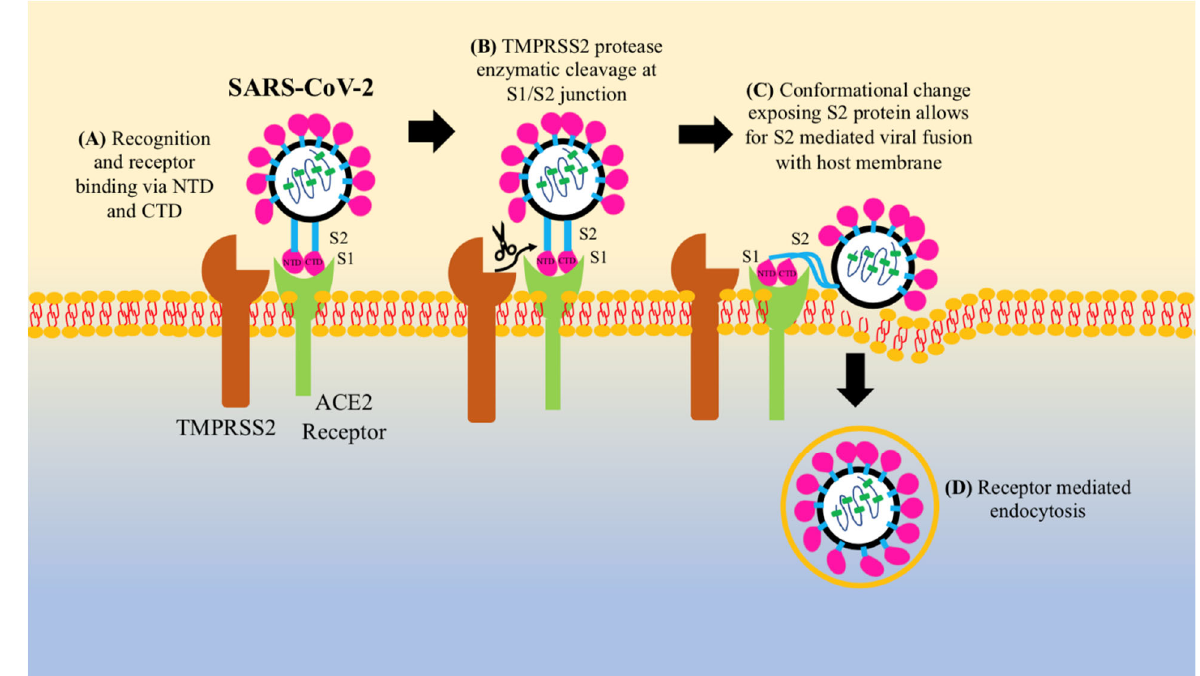
Figure 2. SARS ‐ CoV ‐ 2 mechanism of entry into the host cell. SARS ‐ CoV ‐ 2 is enveloped with a helical nucleocapsid. The envelope is coated by spike proteins, including an S1 and S2 subunit. (A) The S1 subunit has an N ‐ terminal binding domain and a C ‐ terminal binding domain which help with receptor binding and recognition. (B) Once S1 binds to an ACE2 receptor, it undergoes a conformational change with the help of the protease transmembrane protease serine 2 (TMPRSS2) to expose S2. (C) S2 serves as a viral fusion protein that integrates the viral membrane into the host cell membrane. (D) Once fused, SARS ‐ CoV ‐ 2 can enter the cell via receptor mediated endocytosis.